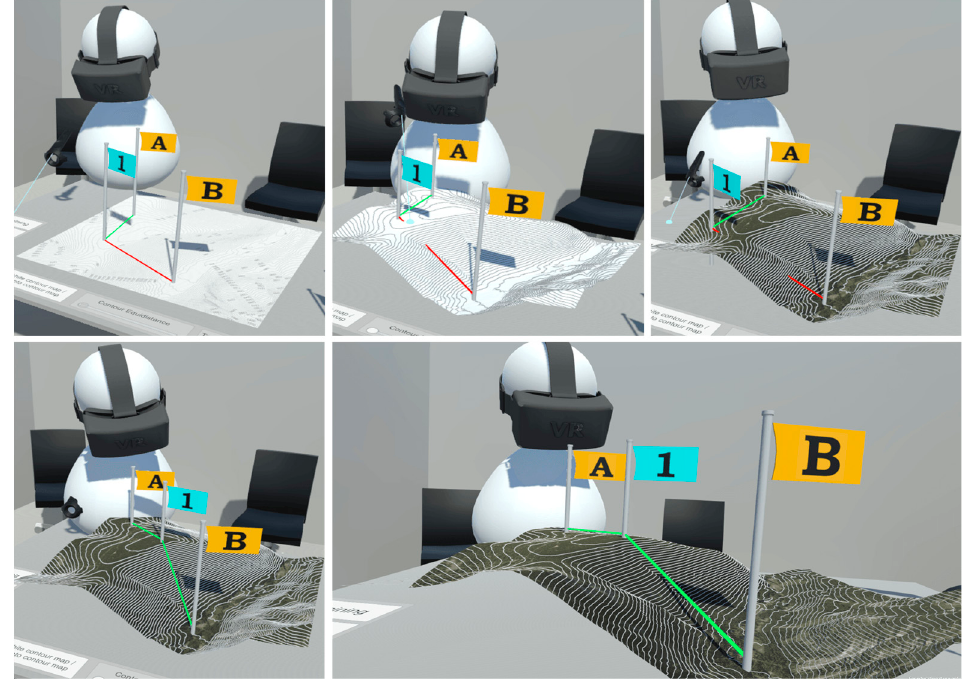
Figure 3. Incorrect ( upper ) and correct ( lower ) answers for the mirror signals task in the collaborative immersive virtual environment (CIVE).